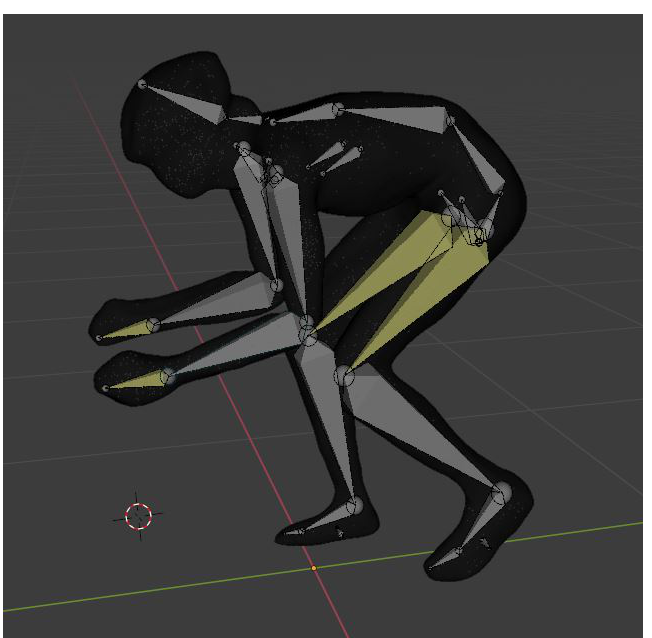
Figure 3. Meshed surface geometry.